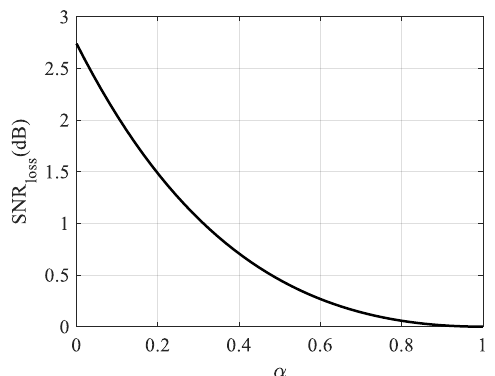
Figure 6. SNR loss caused by windowing during pulse compression.